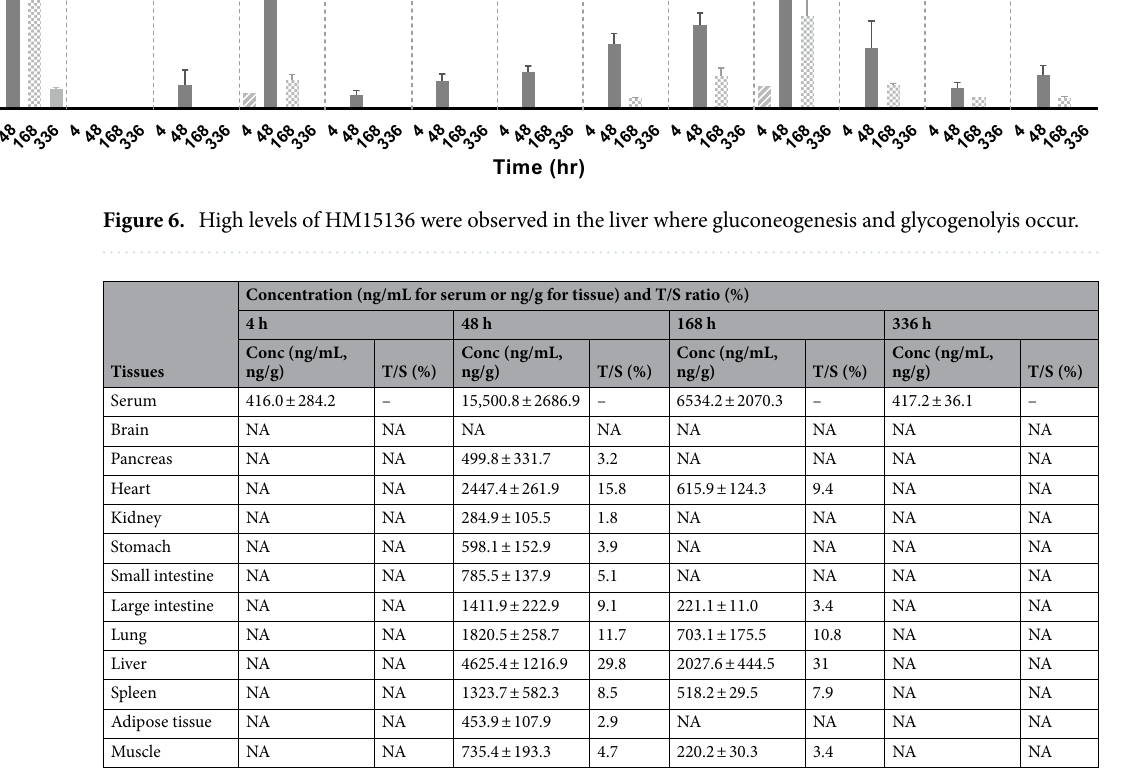
Table 2. Tissue-to-serum ratio (%) and concentration of HM15136 after a single subcutaneous administration in rats. T/S ratio tissue-to-serum ratio, NA not applicable.